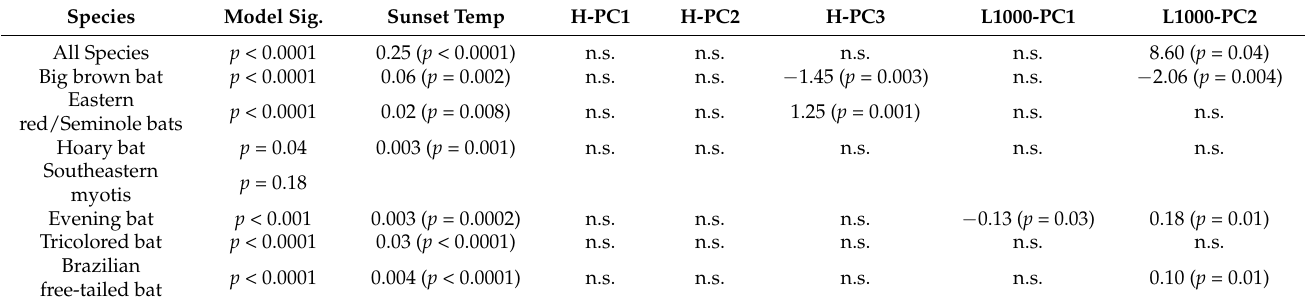
Table 4. Results from linear mixed models comparing number of bat passes for a given species with sunset temperature and each principal component of microhabitat and landscape variables. Nights with sunset temperature below the species-specific threshold were excluded, omitting nights when temperature was too low to expect active bats. Significance of predictor variables was only considered for species where the overall model was significant (Model Sig.). For significant terms, we report parameter coefficients and p